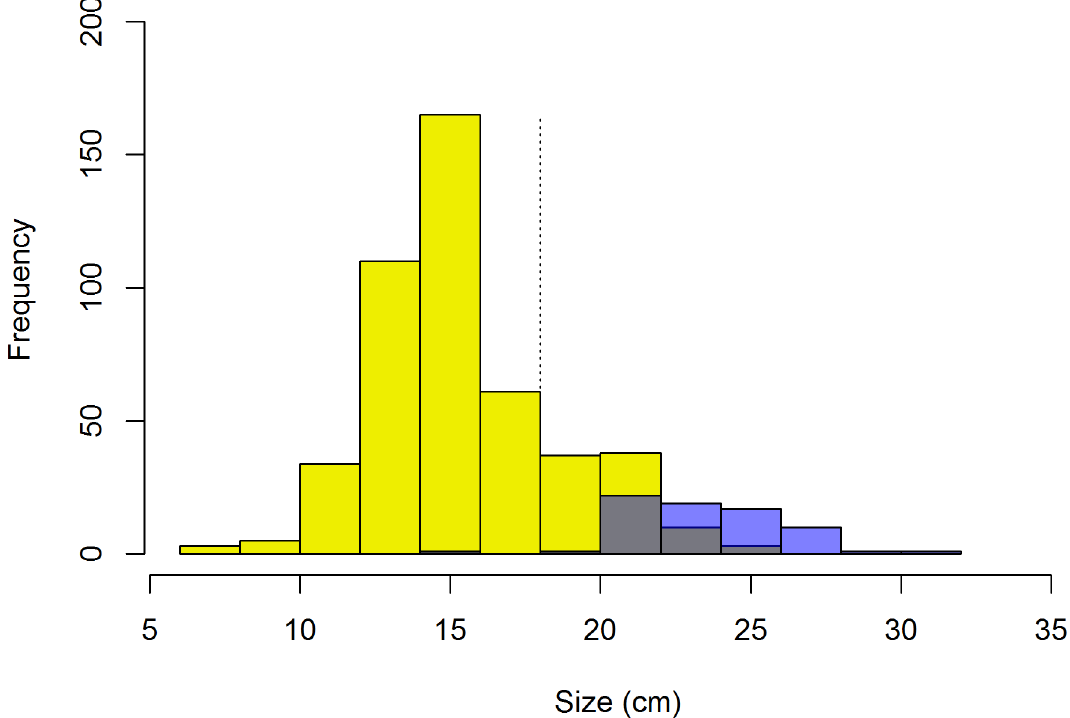
Fig 3. Size distribution of conch in Barbuda. Yellowbars represent juvenile, nonreproductive conch (no flared lip), blue bars represent adult conch (with flared lip), gray representsoverlap. The dashedline at 18 cm indicatesthe legal size of capture for conch in